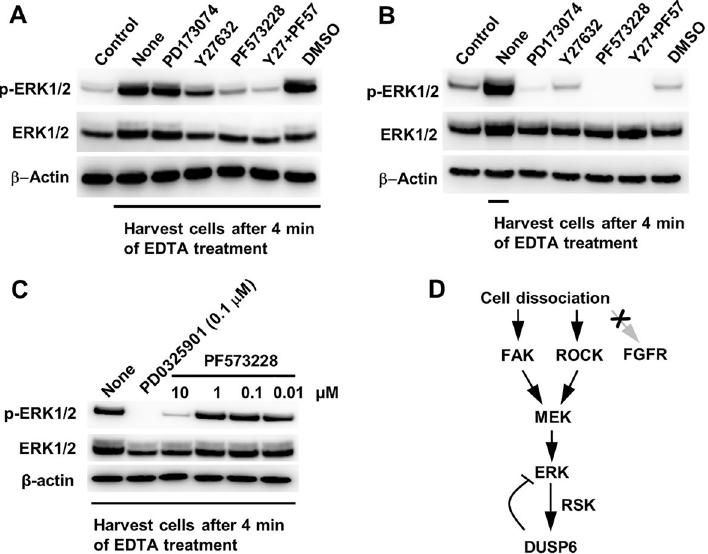
Figure 3. Identification of upstream signals regulating ERK activation in dissociated cells. ( A ) Cells were treated with indicated inhibitors for 1 h before EDTA treatment. Cells were harvested and western blotting was performed. “Control” indicates cells harvested without EDTA treatment. “None” indicates cells harvested after EDTA treatment without treatment of inhibitor. Cells were harvested using scrapper. Following inhibitors were used: PD173074 (0.1 μM) for FGFR, Y27632 (10 μM) for ROCK, and PF573228 (10 μM) for FAK. DMSO was used as a mock ( B ) Cells were treated with indicated inhibitors for 1 h and harvested without EDTA treatment. “None” indicates cells harvested after EDTA treatment without treatment of inhibitor. ( C ) Estimation of optimal PF573228 concentration for ERK suppression following EDTA treatment. Cells were treated with indicated concentrations of PF573228 for 1 h before EDTA treatment. ( D ) Possible signaling pathway regulating ERK activation following cell–cell and cell–matrix